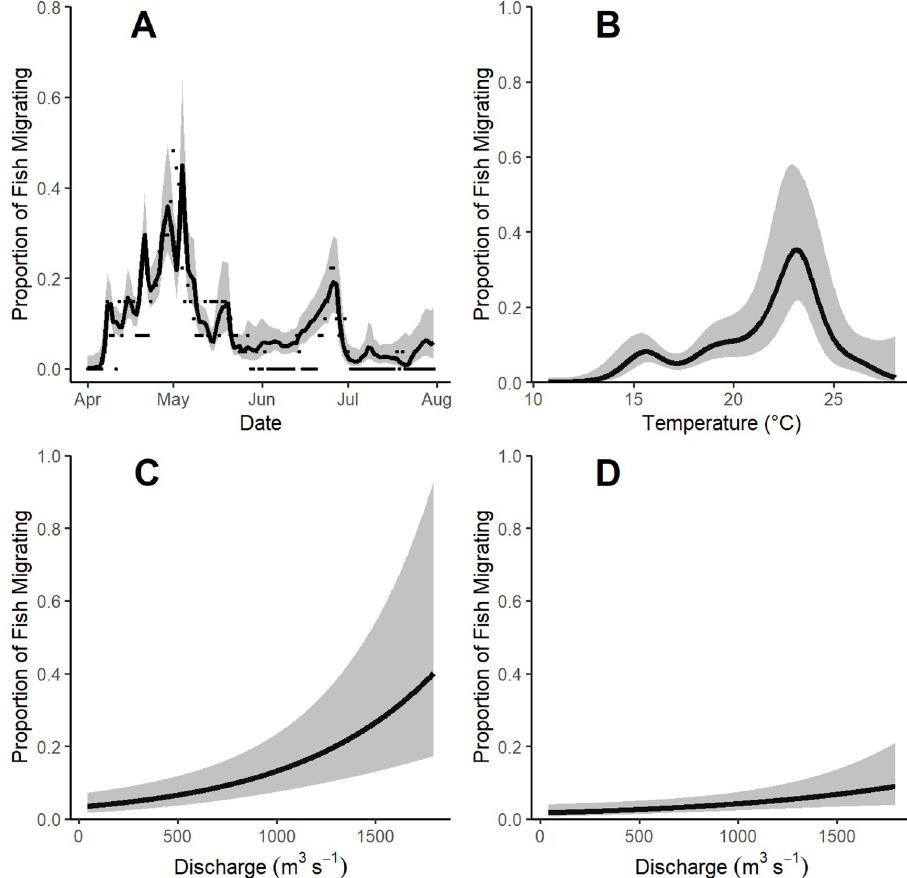
Fig 4. Plot A depicts the generalized additive model (GAM) predicted proportion of tagged grass carp Ctenopharyngodon idella migrating (black lines) with 95% confidence intervals (gray polygon) compared to the observed proportion each day (dots). Plots B through D depict the predicted proportion of tagged grass carp migrating based on a generalized additive model coefficient estimates of the GAM with 95% confidence intervals (gray polygons). Plot B indicates the predicted proportion of fish migrating upstream as a function of temperature while discharge and river stage are held constant at their mean. Plots C and D depict the predicted proportion of fish migrating upstream as a function of discharge with temperature held constant at its mean and river stage held at 11 m and 13 m, respectively.